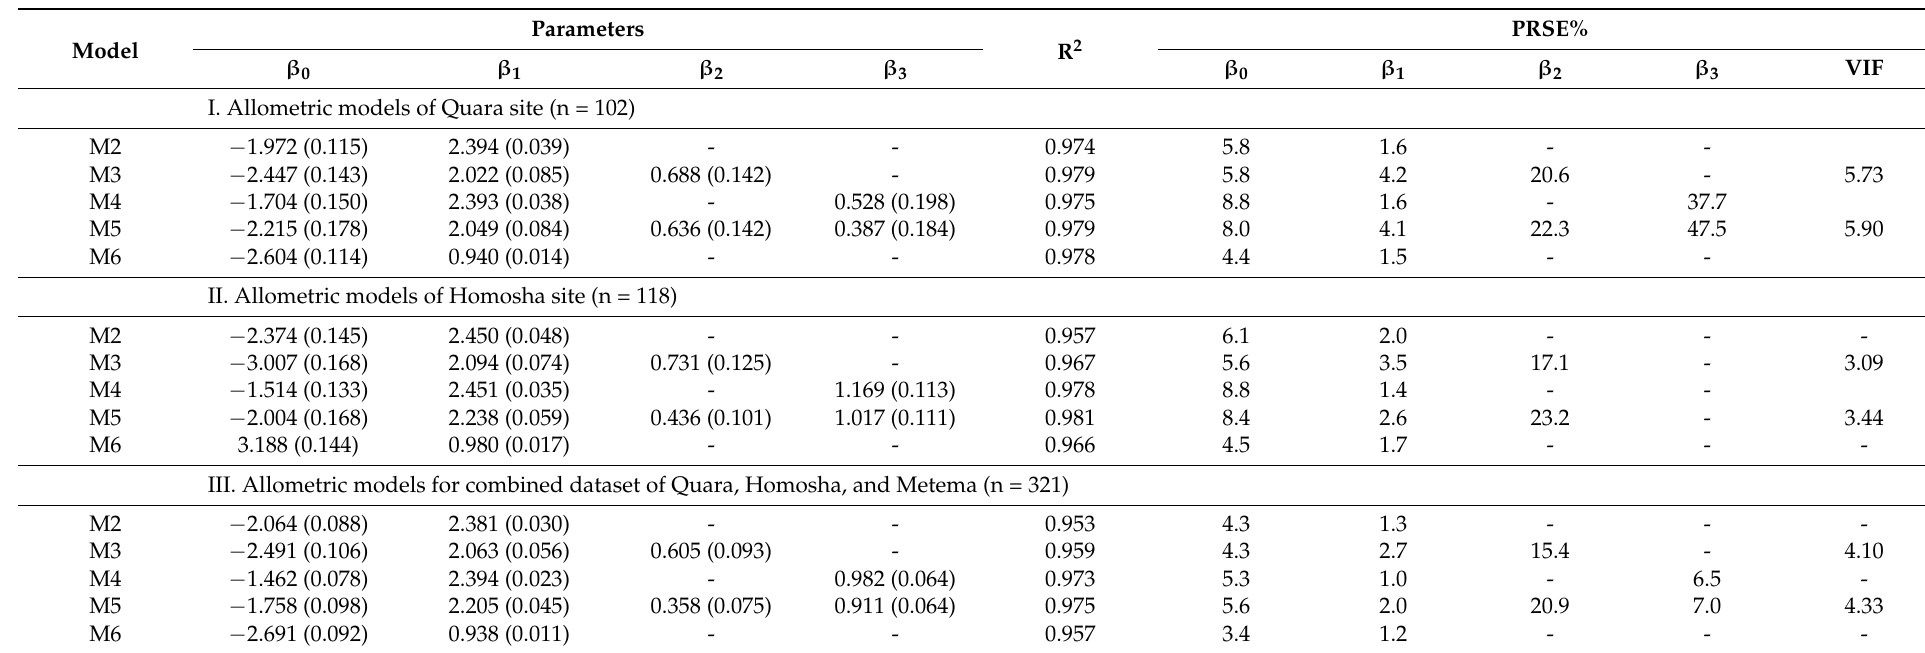
Table A4. The parameters of mixed-species models (and the standard errors) with their PRSE% of the sites and